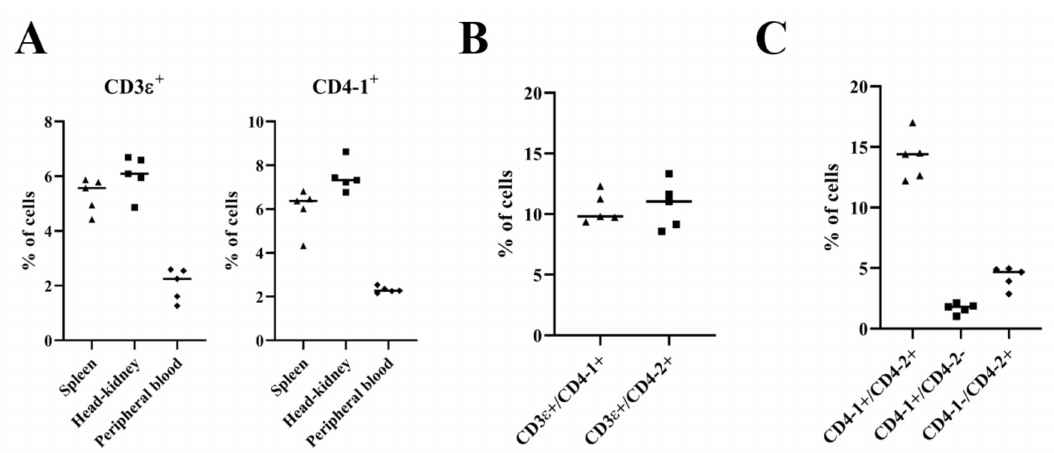
Figure 4. Two-color immunofluorescence staining results of CD3 ε + / CD4-1 + and CD3 ε + / CD4-2 + T lymphocytes, and CD4-1 + / CD4-2 + , CD4 - 1 + / CD4-2 - and CD4-1 - / CD4-2 + T lymphocytes in head-kidney leukocytes. ( A ) Percentage of CD3 ε and CD4-1 positive cells in the spleen, head-kidney and peripheral blood analyzed by flow cytometry. ( B ) Percentage of CD3 ε + / CD4-1 + and CD3 ε + / CD4-2 + cells in head-kidney. ( C ) Percentage of CD4-1 + / CD4-2 + , CD4-1 + / CD4-2 - and CD4-1 - / CD4-2 + cells in head-kidney. Data are represented as the mean ± SEM of positive cells over the total lymphocytes of at least five